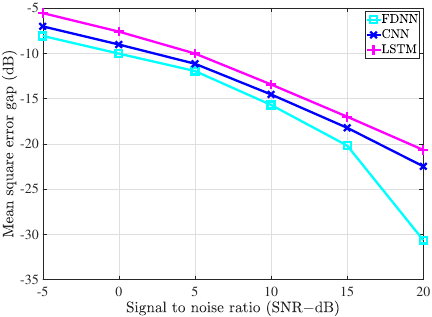
Figure 10. The MSE of the channel estimate vs. the SNR level with f D = 200 Hz.